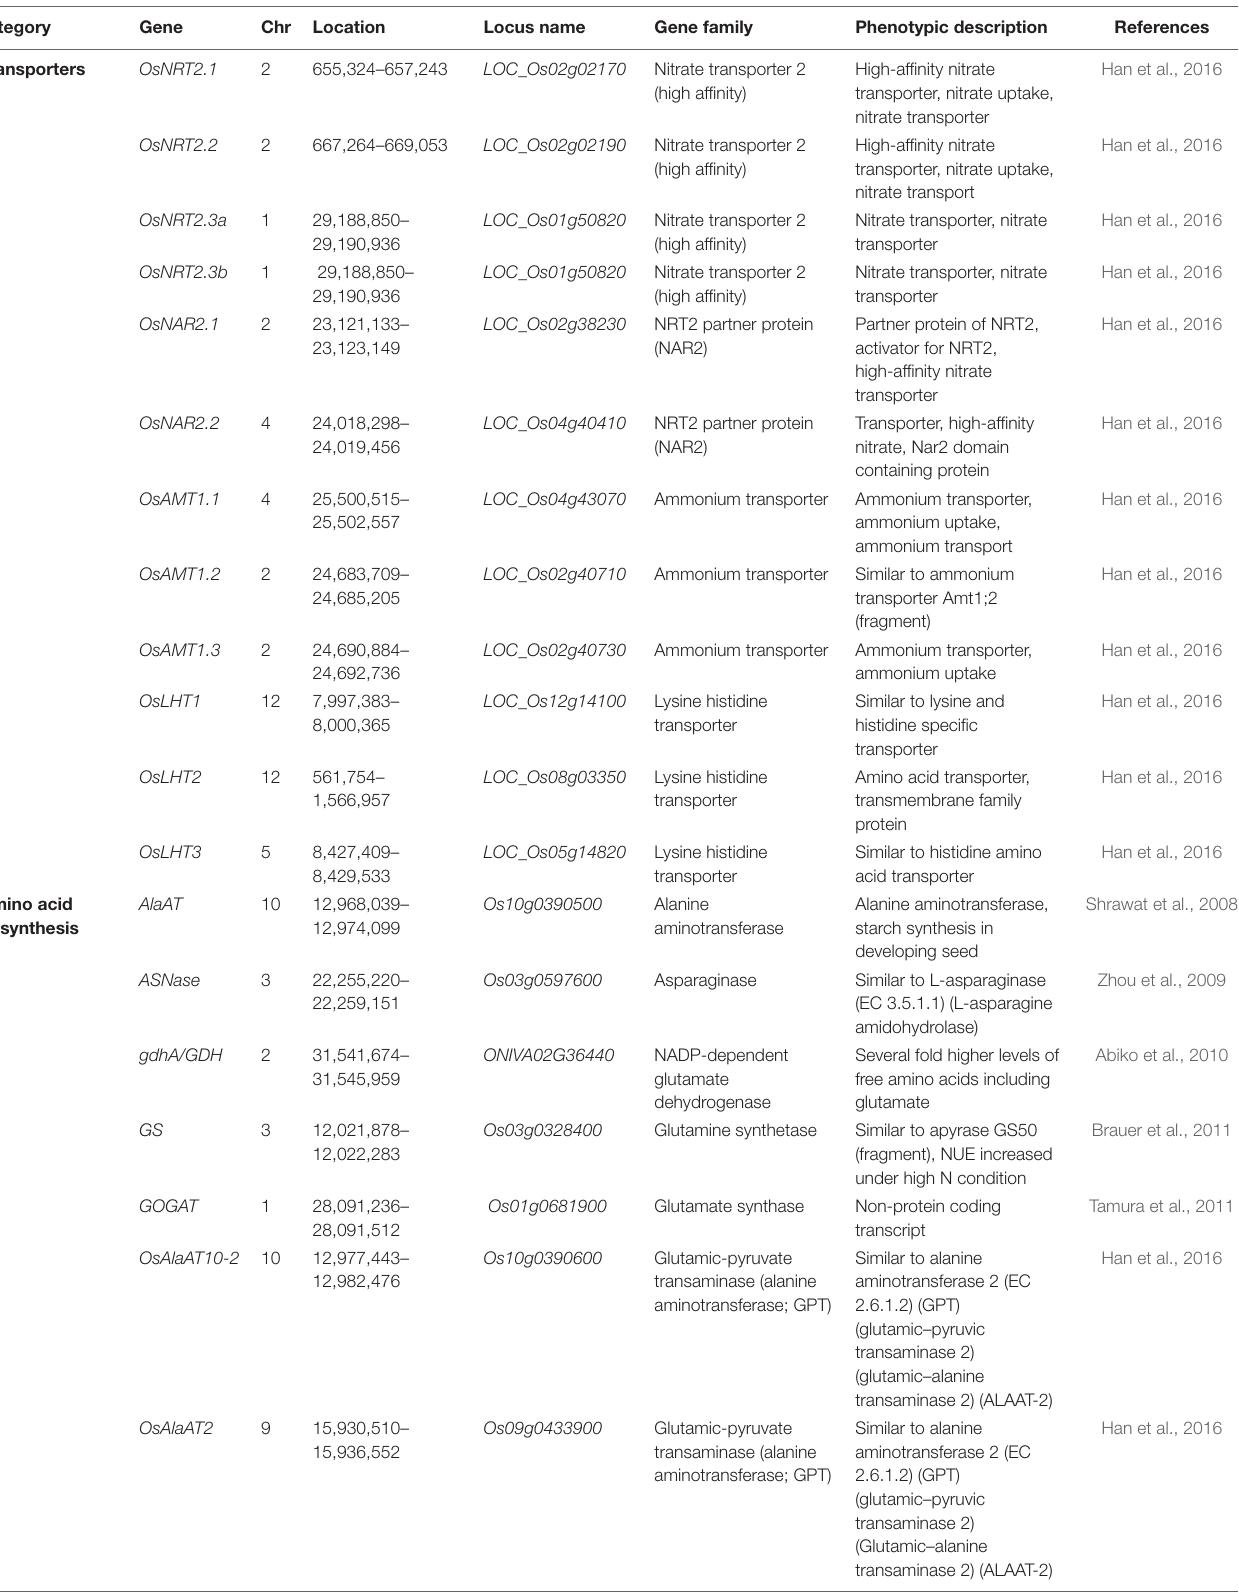
TABLE 5 | Detailed description of network genes associated with nitrogen use efficiency in rice